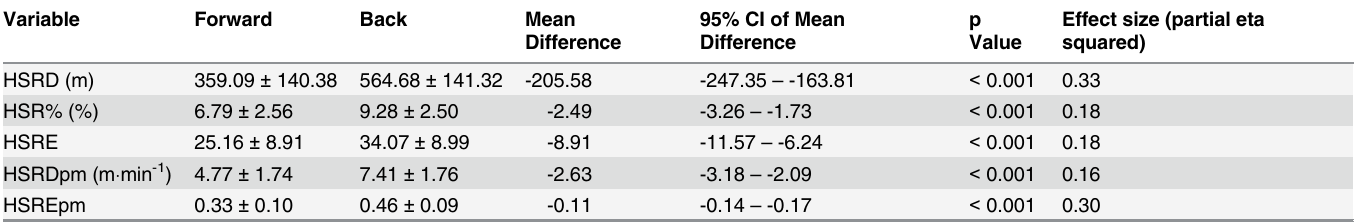
Table 3. Forward vs back IND HSR demands.